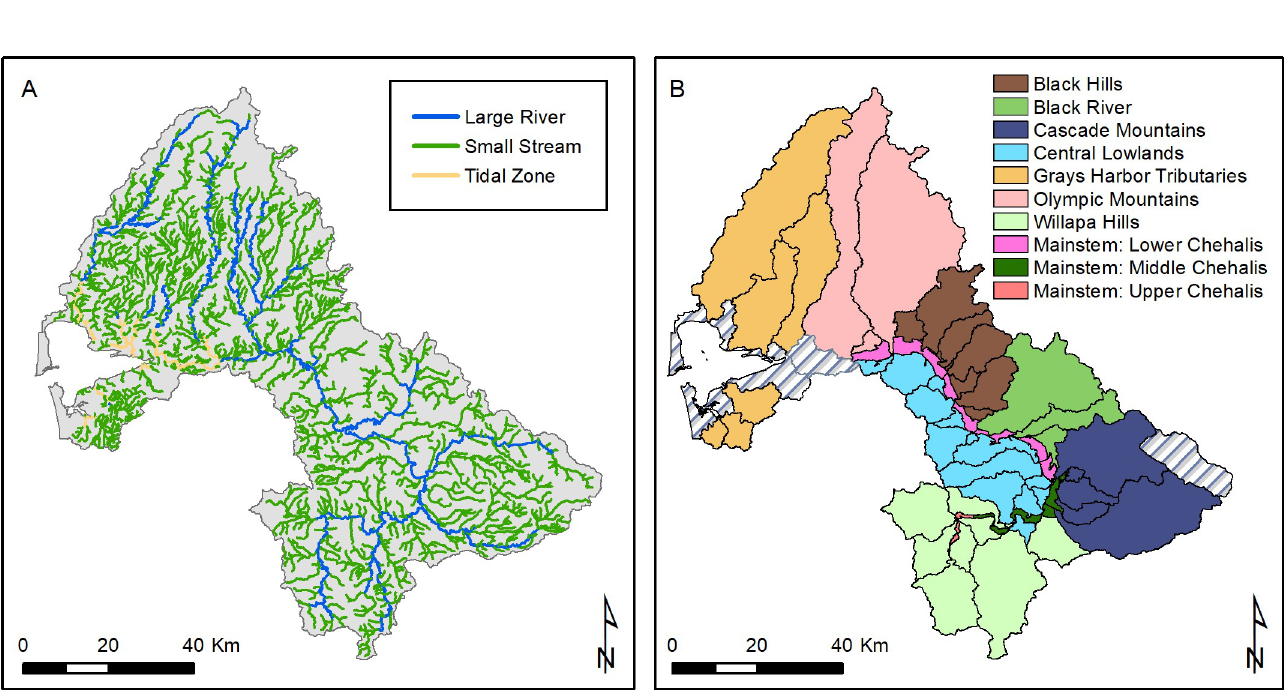
Fig 4. Model spatial structure. Distribution of large rivers (bankfull width > 20 m) and small streams ( < 20 m bankfull width) in the Chehalis River basin (left panel). Map of the 63 subbasins (black boundaries) and Ecological Regions (colored regions) (right panel). Gray-striped subbasins are not included in Ecological